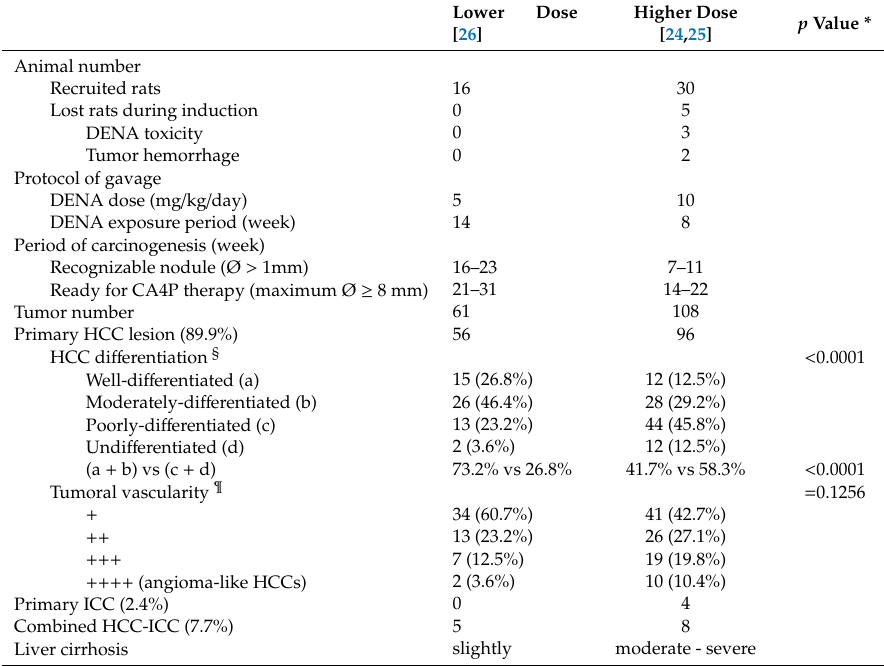
Lower Dose Higher Dose p Value * [26] [24,25]